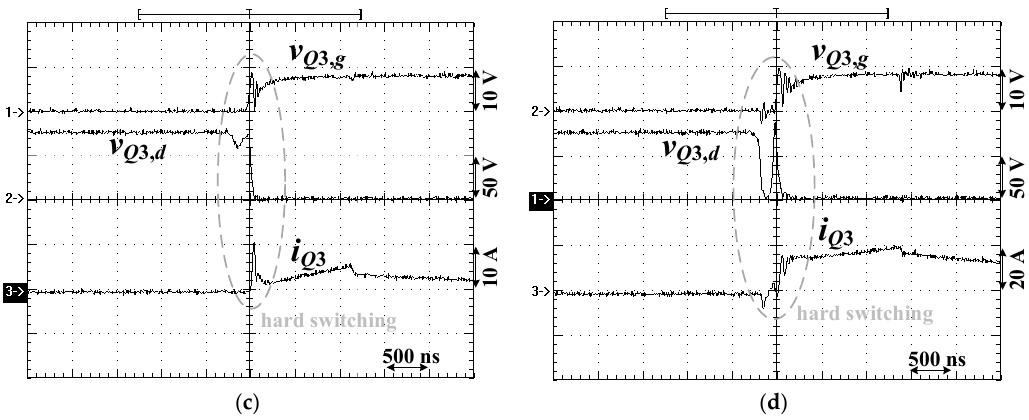
Figure 9. Experimental waveforms of the lagging-leg switch Q 3 in low input voltage range at ( a ) 25 V input and 20% load ( b ) 25 V input and 100% load ( c ) 75 V input and 20% load ( d ) 75 V input and 100% load.